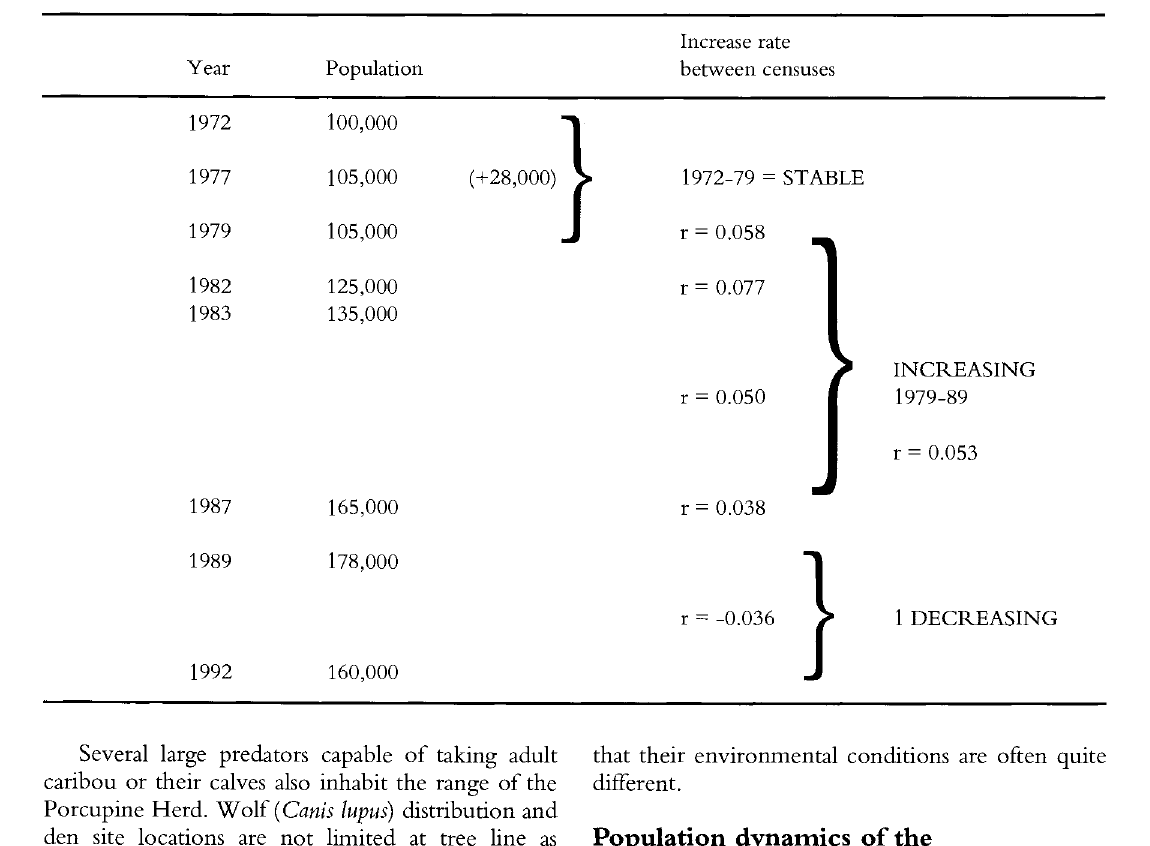
Table 1. Population size and rates of increase of the Porcupine caribou herd,